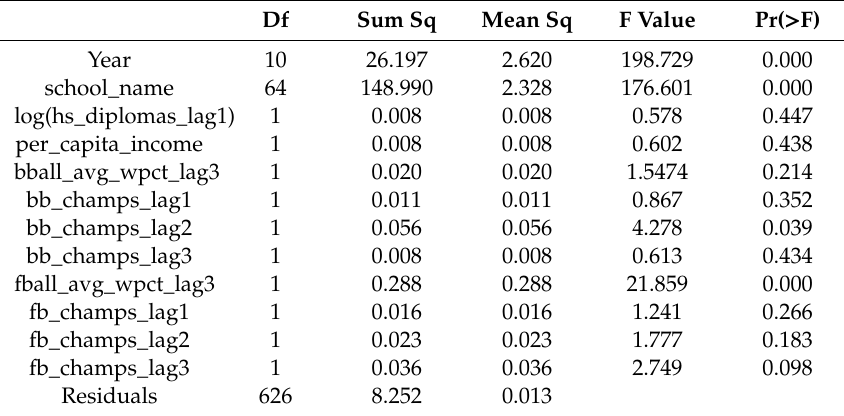
Table A1. ANOVA table for